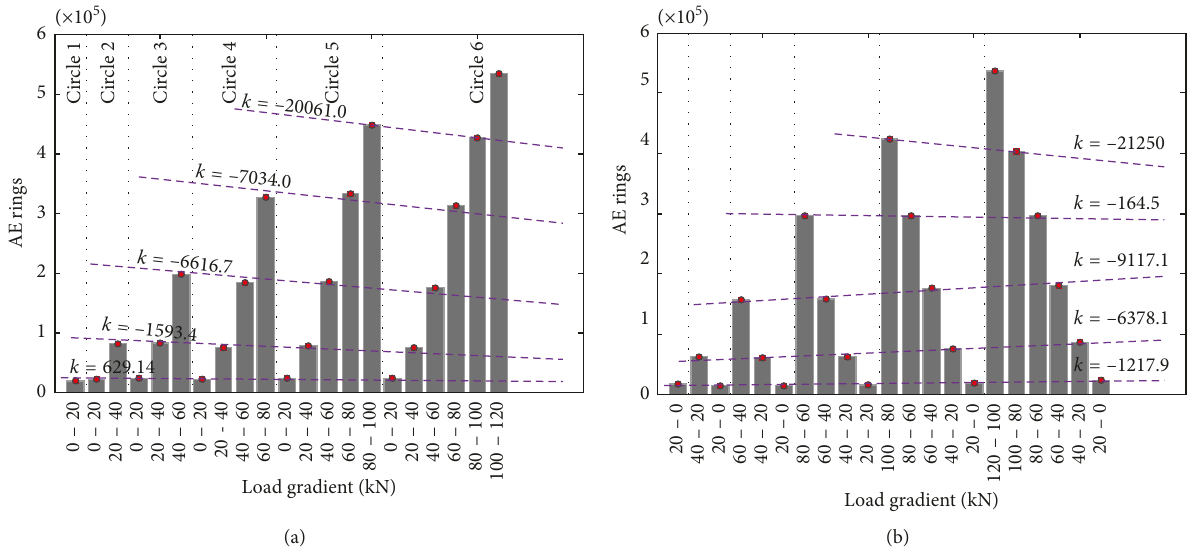
Figure 4: Changes of the AE rings with load gradients. (a) Cyclic loading phases; (b) cyclic unloading phases.